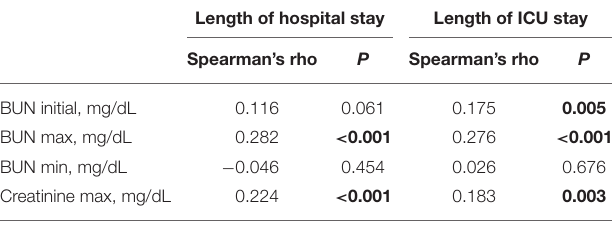
TABLE 2 | The correlation of BUN and creatinine with hospital stay and ICU stay.